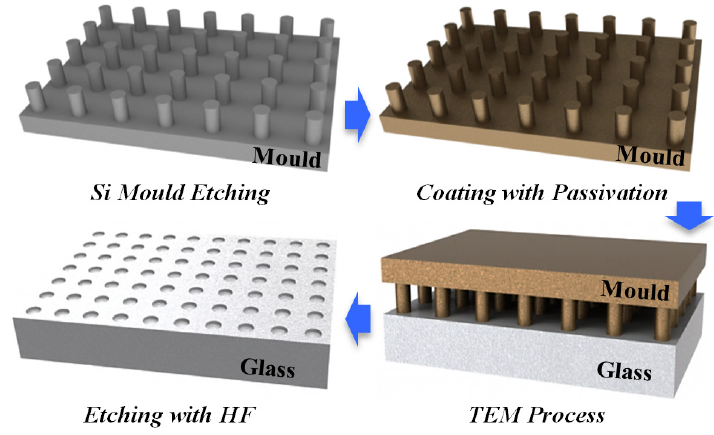
Figure 4. Flowchart of thermal electrical modified etching for structure micromachining.